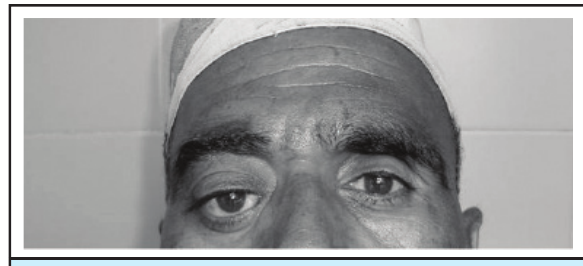
years, more since last 2 months (Figure 1).